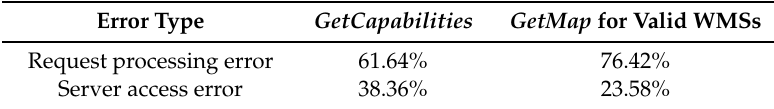
Table 5. Error types in GetCapabilities and GetMap operations.